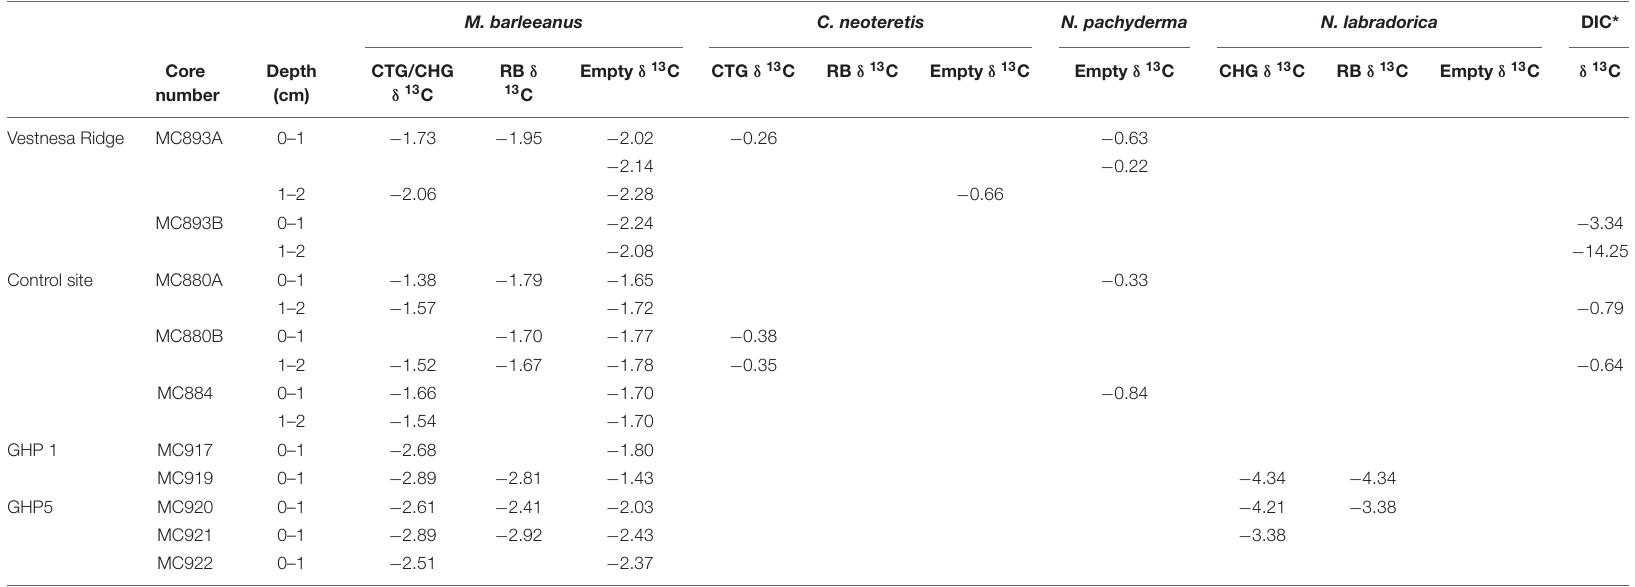
V-PDB) of Melonis barleeanus , Cassidulina neoteretis , and Neogloboquadrina pachyderma , and dissolved inorganic carbon (DIC; *Bernhard and Panieri, 2018) from TABLE 5 | Carbon isotope values ( δ 13 C; Vestnesa Ridge and control site; and Melonis barleeanus and Nonionellina labradorica from Storfjordrenna pingo from active GHP1 and inactive GHP5; CellTracker TM Green CMFDA (CTG), CellHunt Green (CHG), Rose (cid:104) Bengal (RB) individuals, and empty